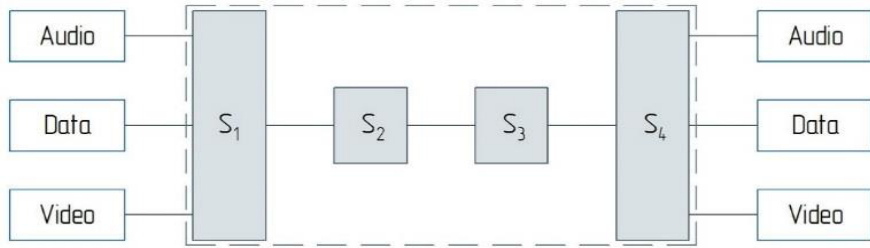
Figure 5. Example of network topology for sequential test scenario